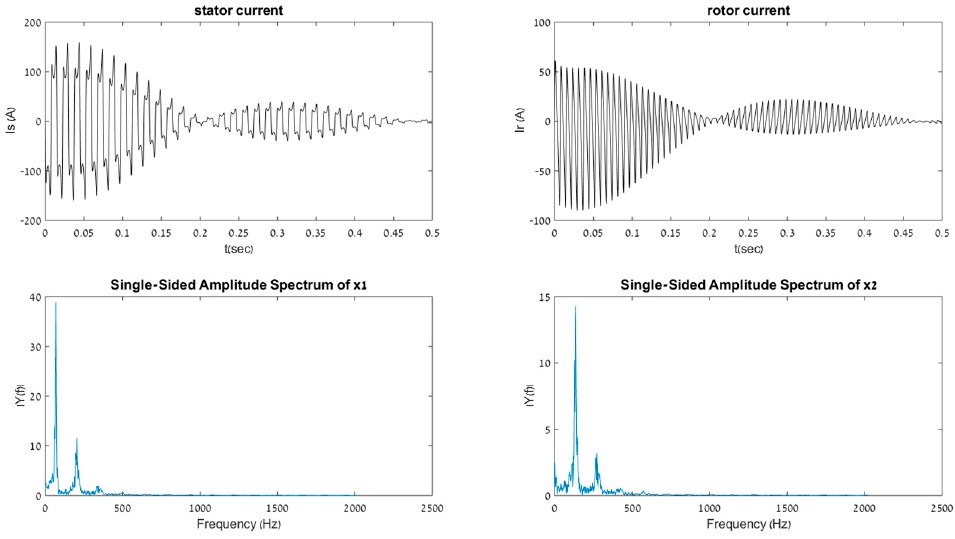
Figure 18. A computer simulation of IG with L s = 0.21 H, R s = 9 Ohm, with rotor current and FFT.